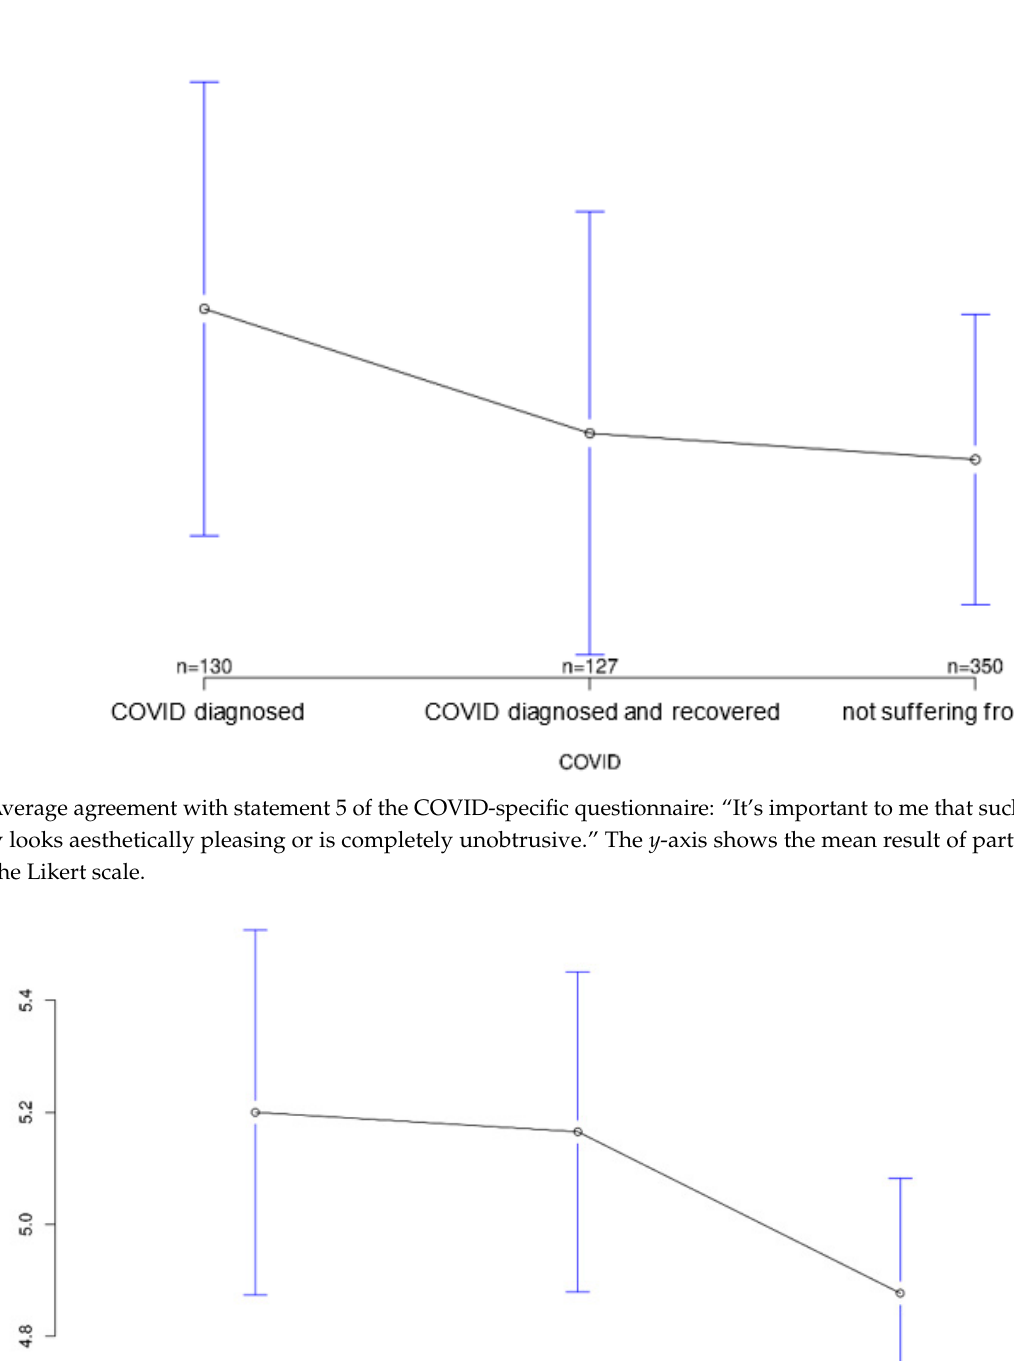
monitoring could help reassure family and friends as my health would always be medically monitored.” The y -axis shows